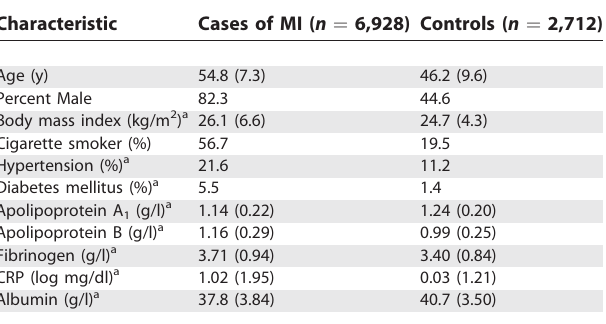
Table 2. Characteristics of Confirmed Myocardial Infarction Cases and Controls (Mean [SD] or